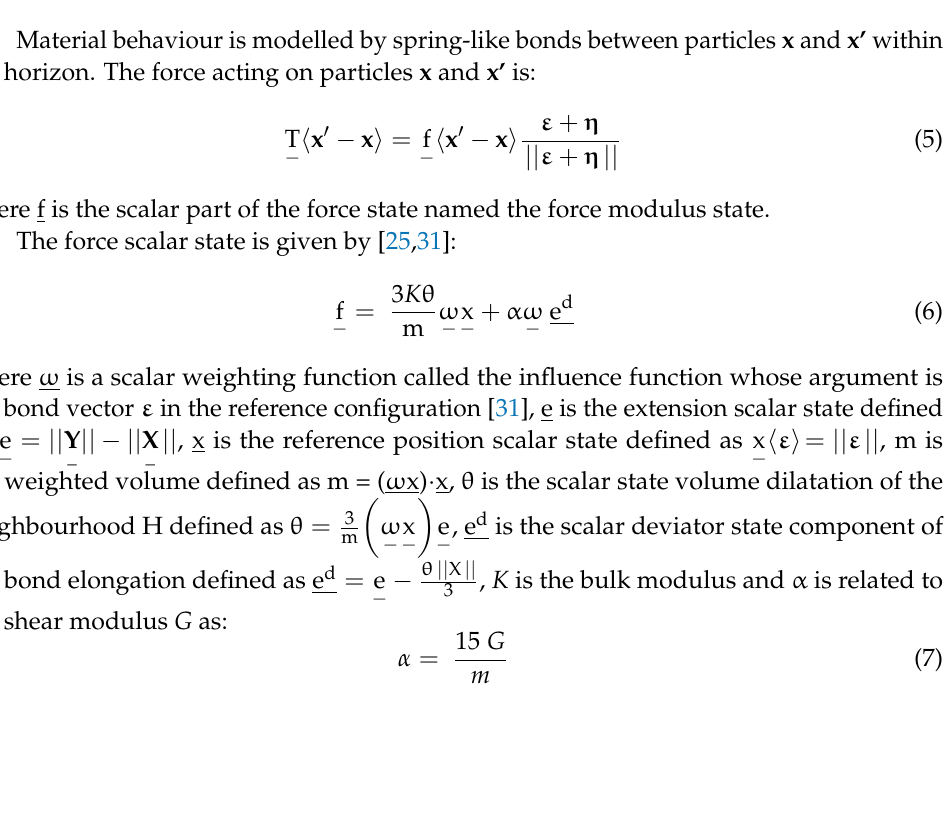
Figure 1. Deformation of the bond involved in (4) and in relation to the reference state ε , the deformation state η and the displacement state U.